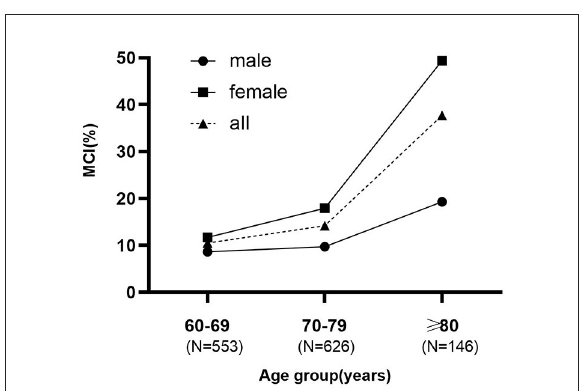
FIGURE2 The prevalence increased more steeply with age in females than